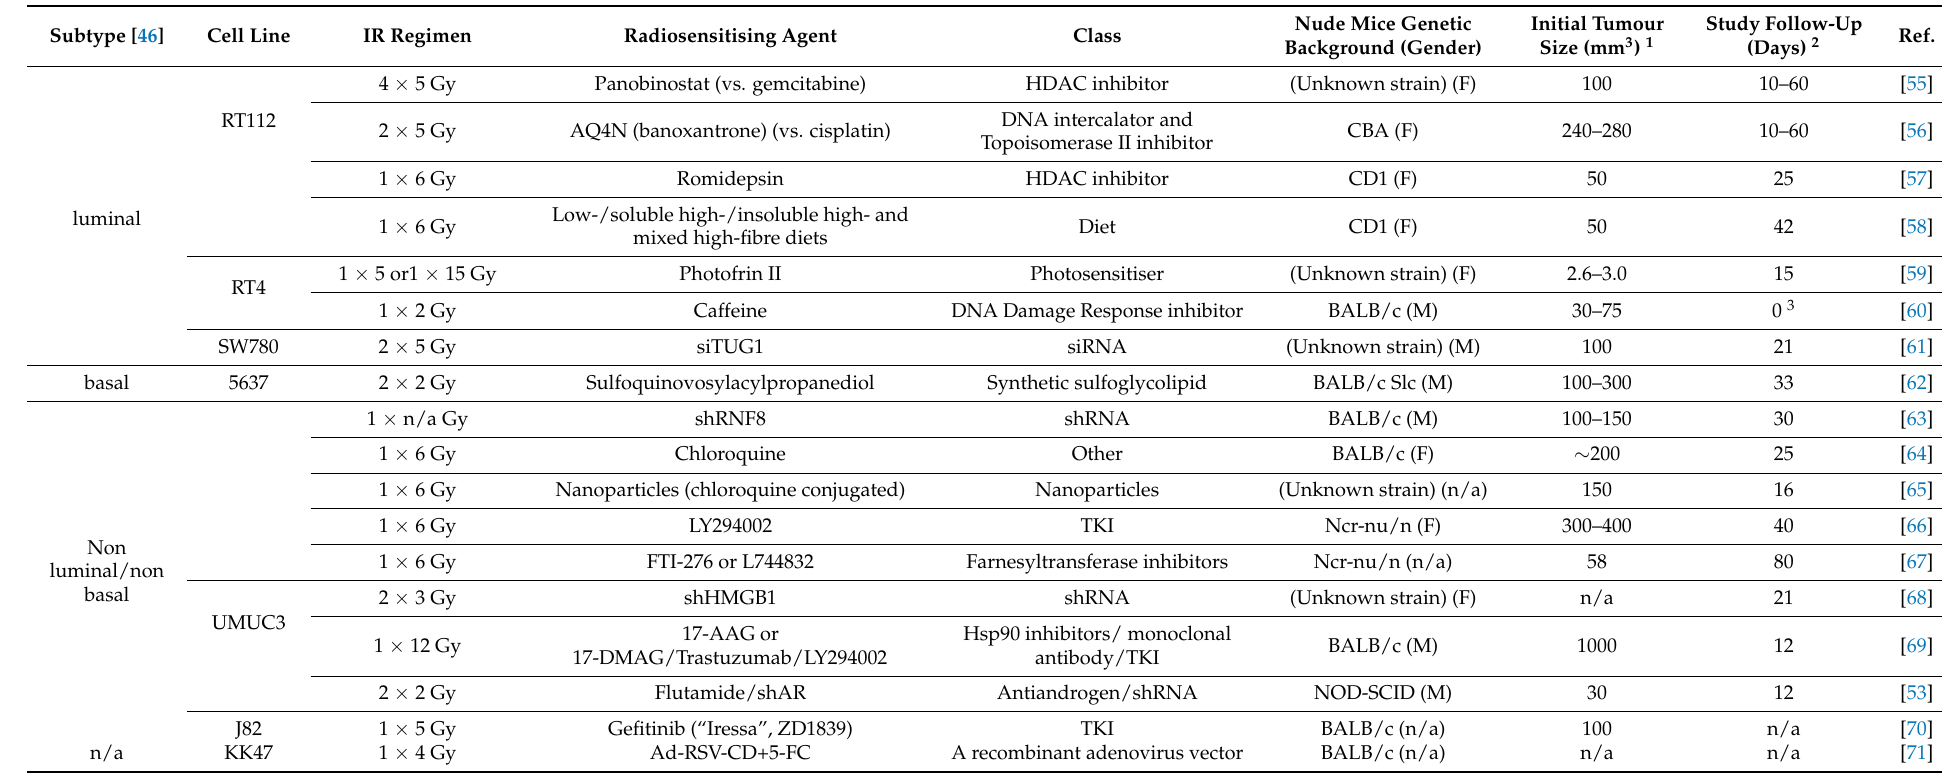
Table 3. Overview of human BCa cell line xenograft models used in radiosensitisation